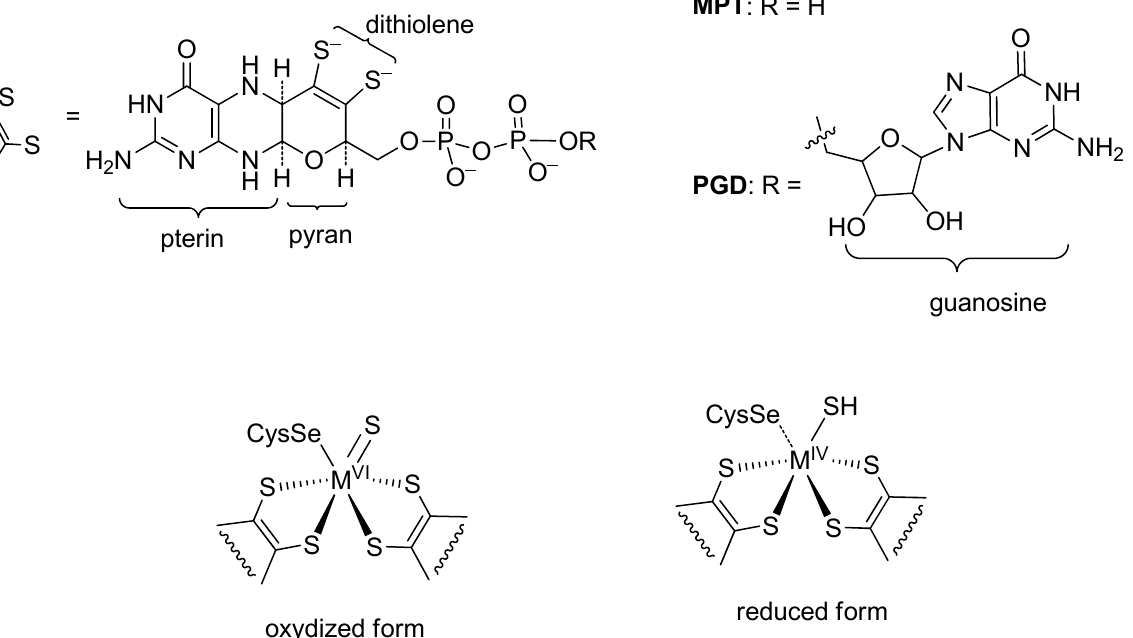
Figure 2. Structures of PGD and MPT ( top ) and active site of FDHs: M = Mo/W ( bottom ). The presence of the selenocysteine ligand in the reduced form is